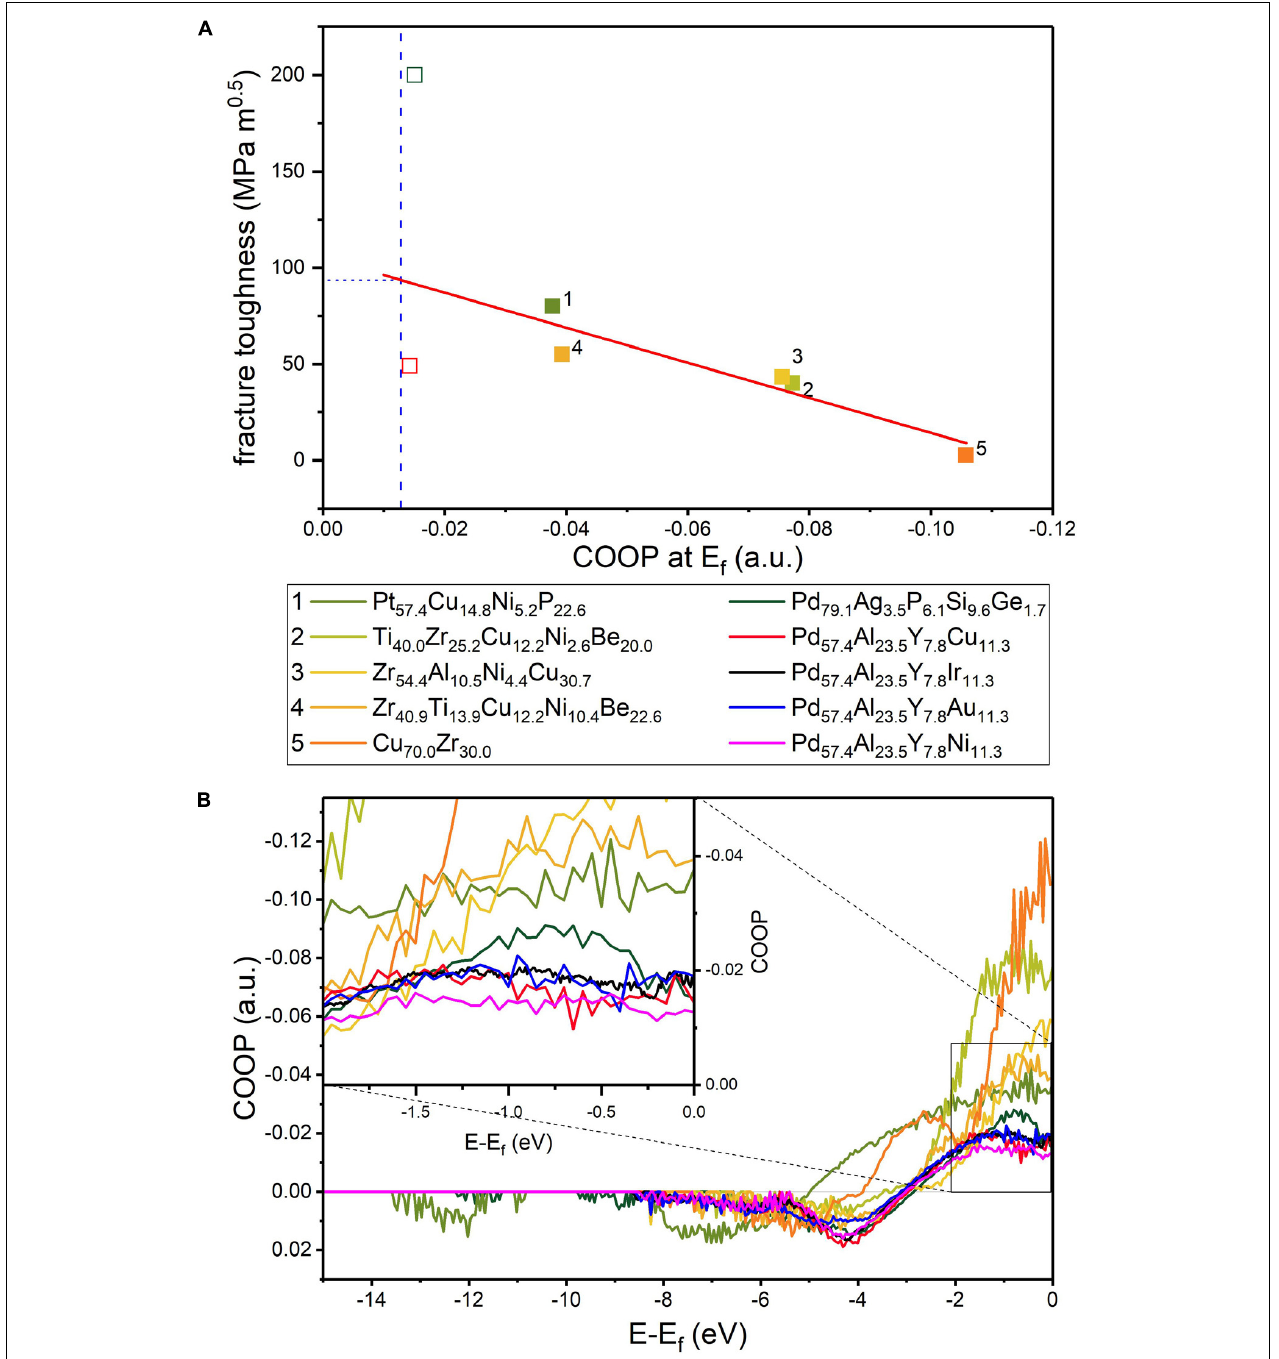
FIGURE 5 | (A) Fracture toughness as a function of COOP at the Fermi level. Open symbols are not included in the fit as they may be sample size dependent (Evertz et al., 2020). The vertical dashed blue line indicates the COOP of Pd 57 . 4 Al 23 . 5 Y 7 . 8 Ni 11 . 3 (B) COOP of the glasses shown in (A) . Reproduced from Evertz et